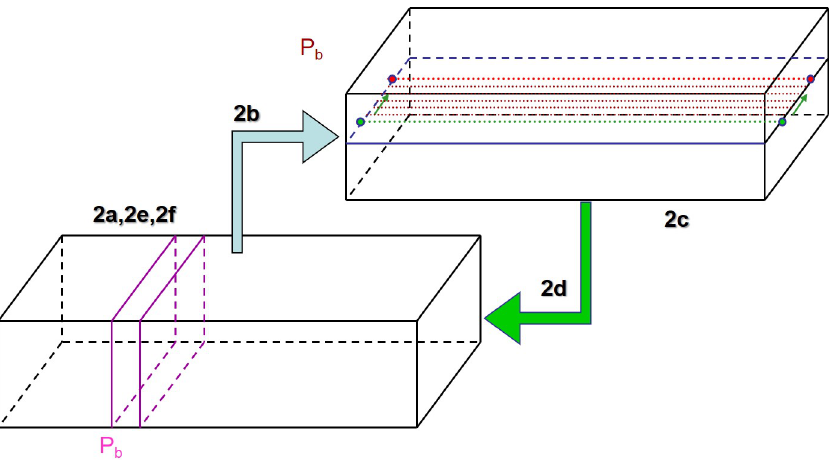
Figure 2. Parallelization scheme of the